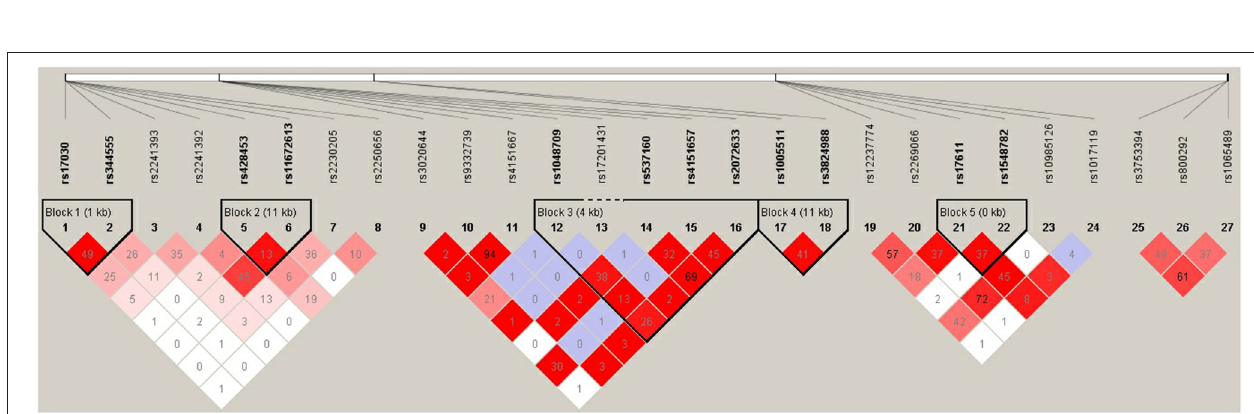
Frontiers in Immunology |